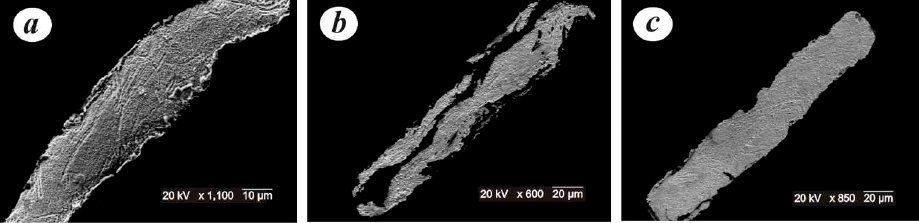
Figure 7. Internal structures of pseudo-ore flake gold (cross section): ( a , b ) flake gold particles with numerous lines of deformations; ( c ) granulation structures and numerous deformation lines.